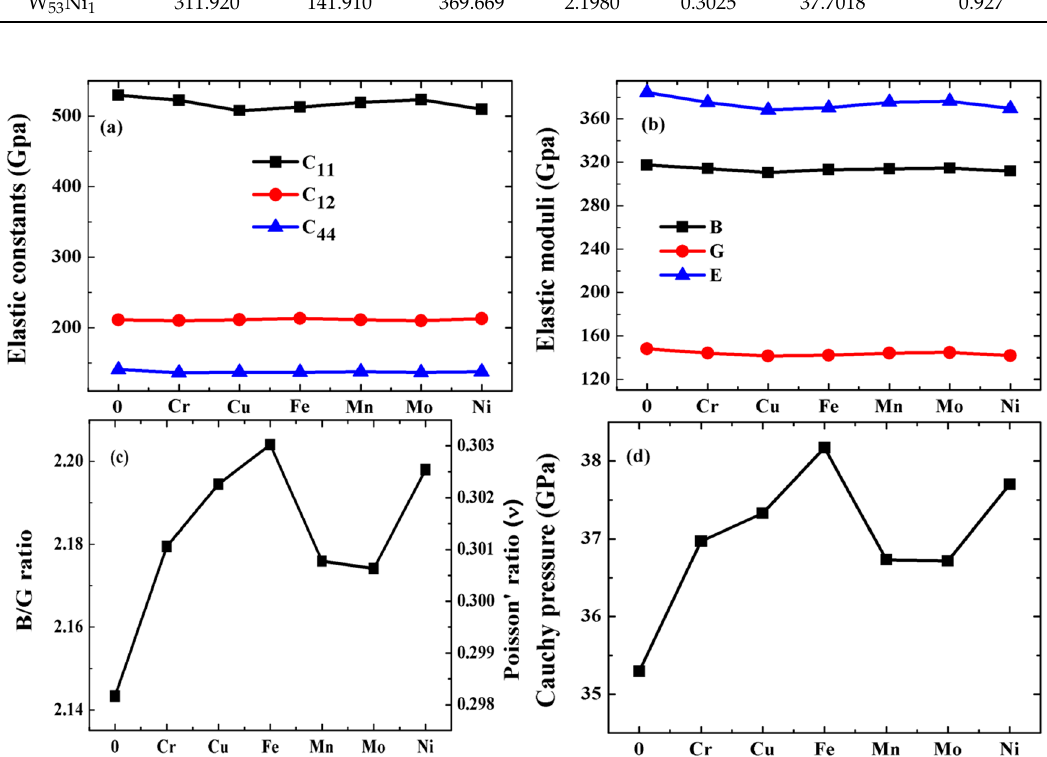
Figure 4. Elastic constants ( a ), elastic moduli ( b ), Poisson’s ratio and B/G ratio ( c ) and Cauchy pressures ( d ) of pure W and the W-TM (TM = Cr, Cu, Fe, Mn, Mo and Ni, respectively) alloys.